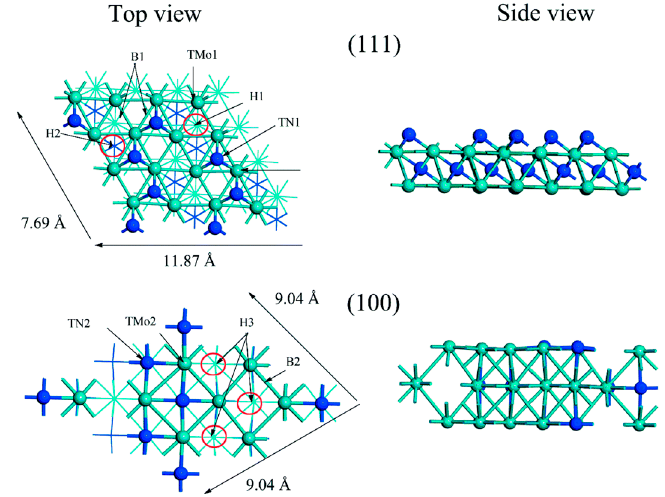
Figure 8. H 2 adsorption sites on Mo 2 N (111) and (100) faces. Reproduced from [48], with permission from American Chemical Society, 2016.